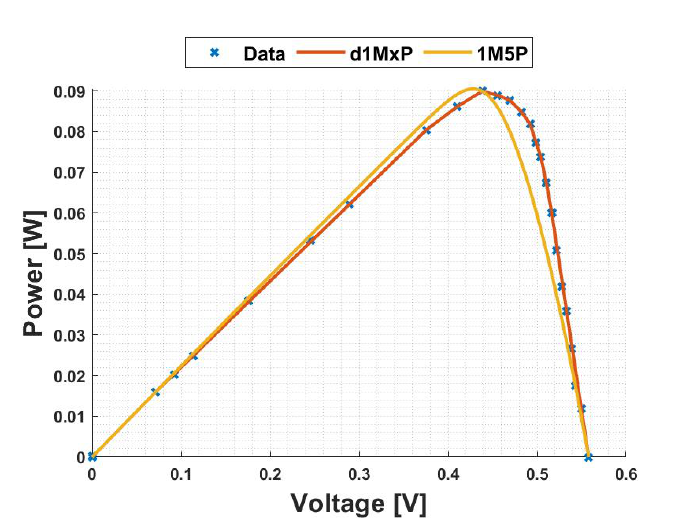
Figure 7. P-V curves using the 1M5P model and the proposed model, at T = 25 ◦ C.